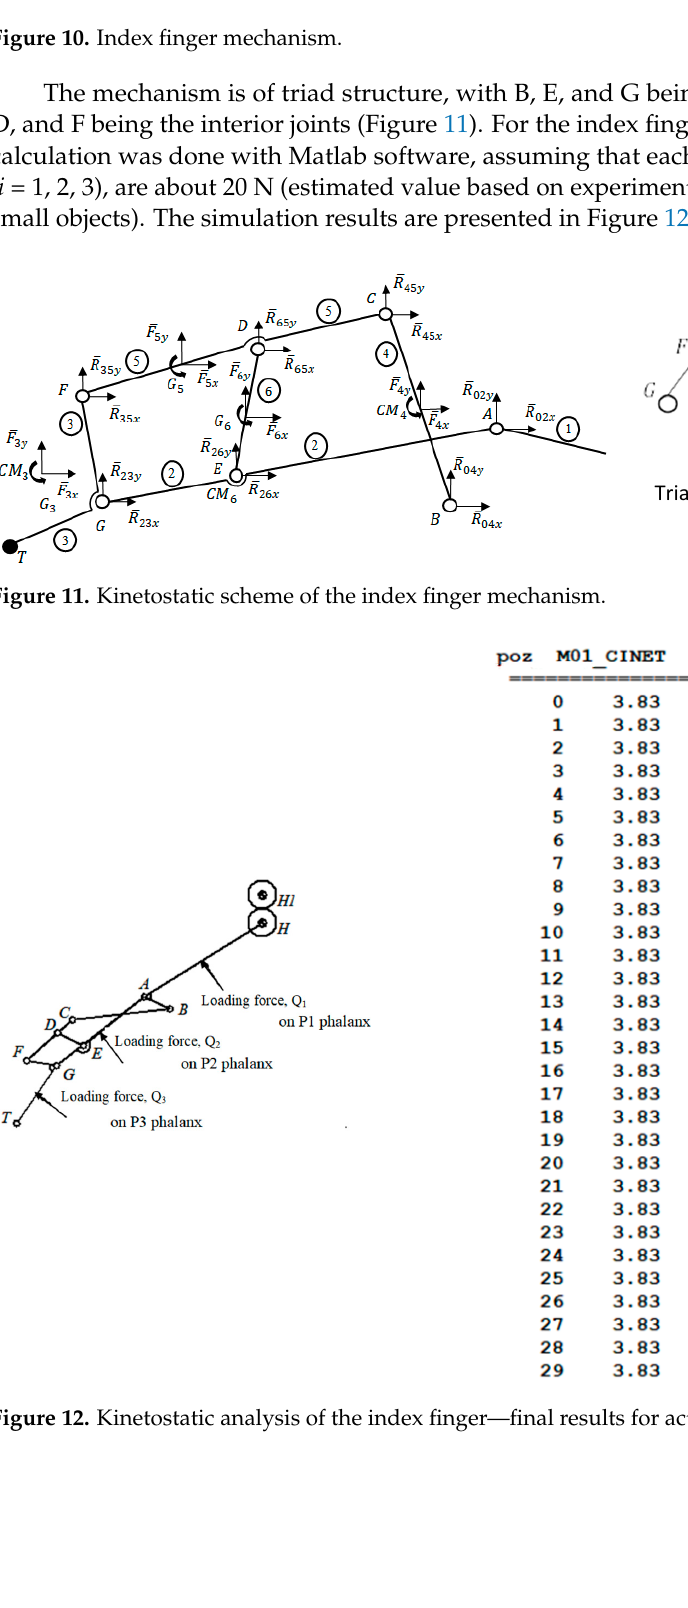
Figure 10. Index finger mechanism.